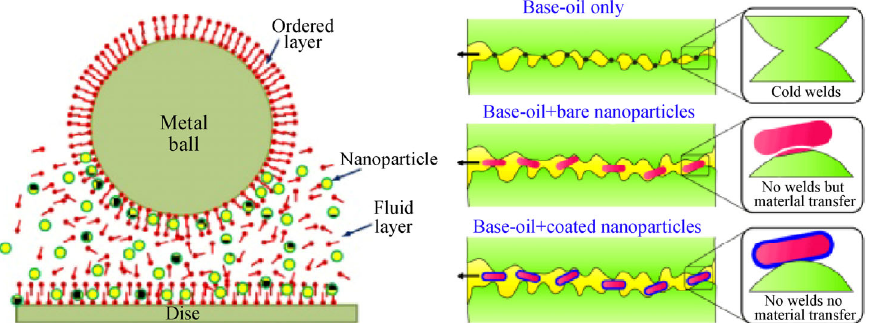
Fig. 5 (left) Core-shell structure of NP on the disc; (right) comparison of the effect of three types of lubrication conditions on cold-welding and material transfer behavior of a